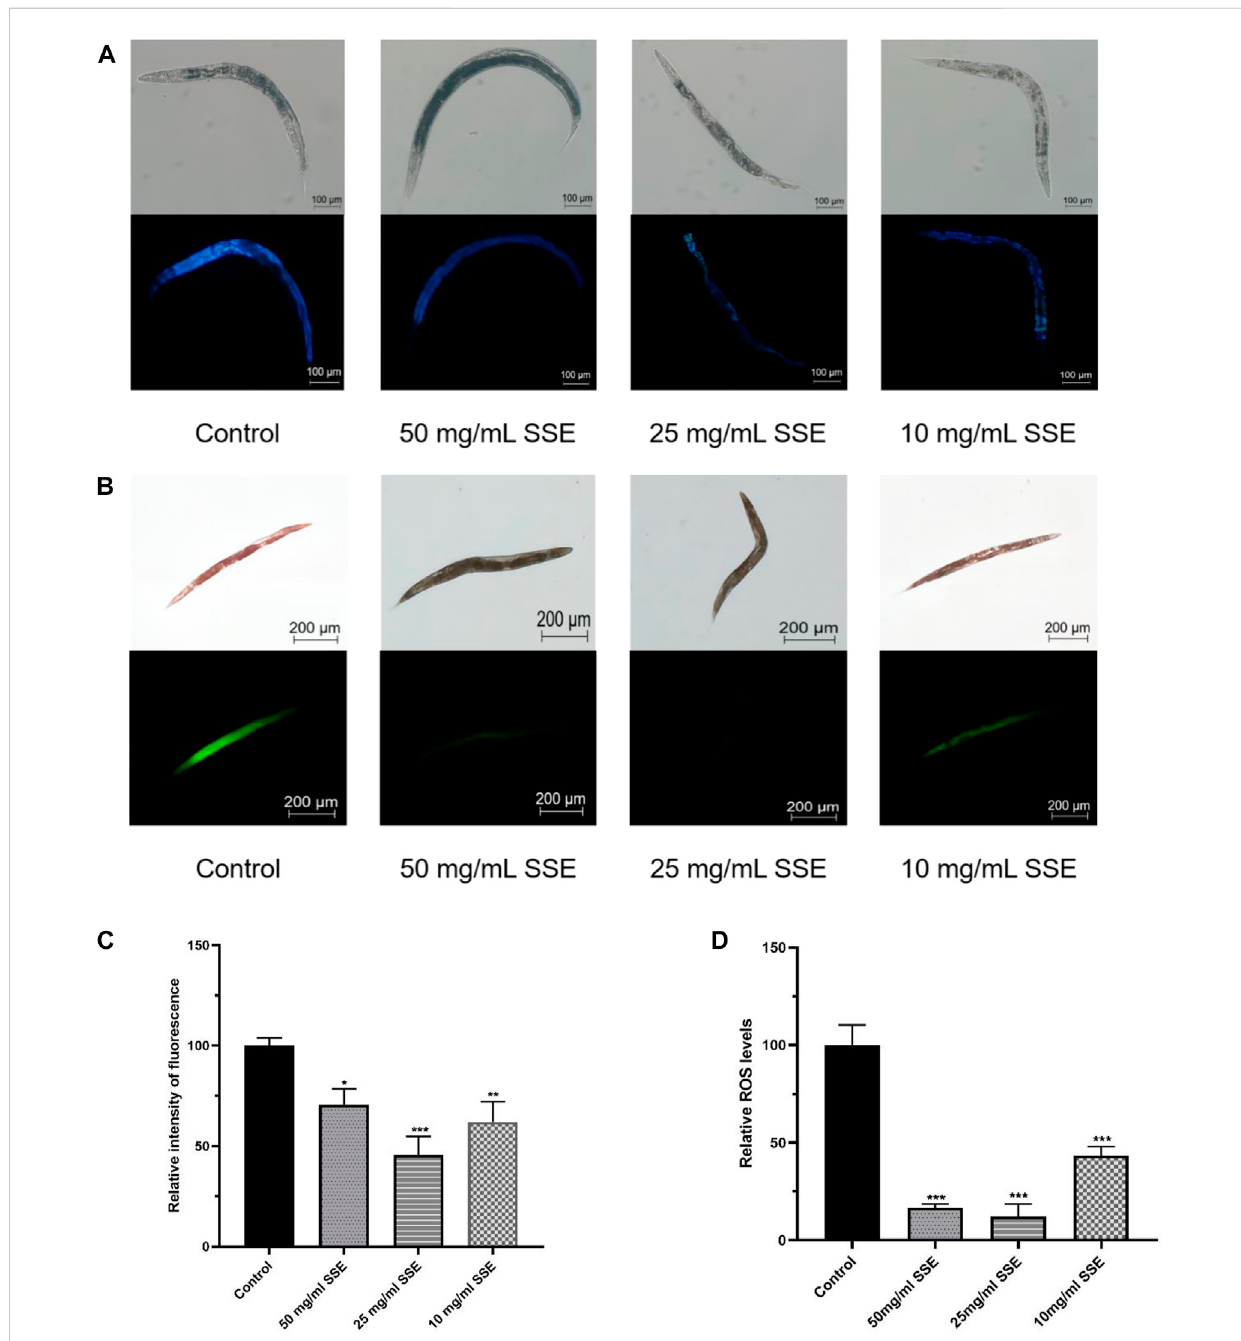
FIGURE 3 Effects of SSE on lipofuscin and ROS accumulation. (A) The lipofuscin accumulations were measured with a fl uorescence microscope (B) Representative pictures of the ROS accumulations of Caenorhabditis elegans (C) ImageJ software was used to determine the relative fl uorescence intensities. (D) ImageJ software was used to determine the relative fl uorescence intensities. * p ≤ 0.05, ** p ≤ 0.01, *** p ≤